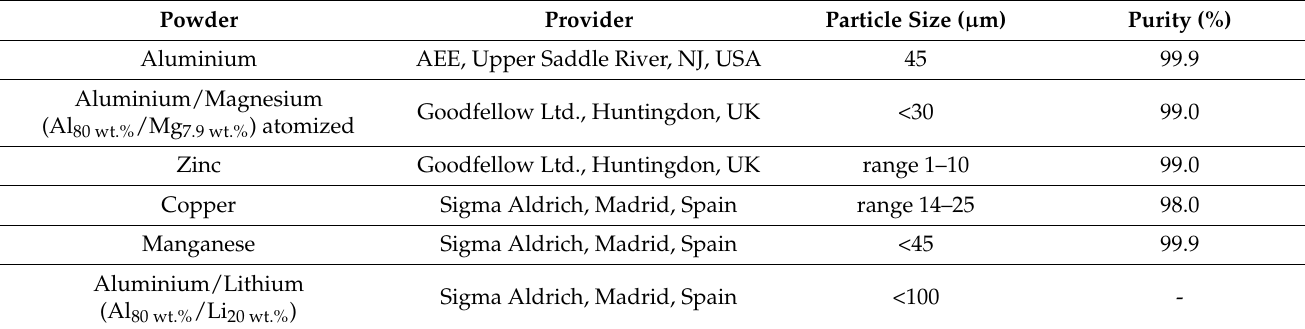
Table 1. Characteristics of powders. Aluminium and alloying elements.